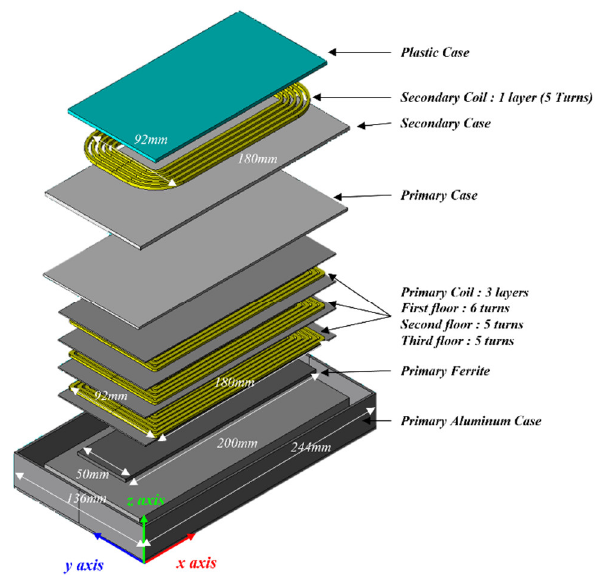
Figure 7. Loosely coupled transformer 3D model. Table 2. Designed dimensional parameters of LCT. Parameters